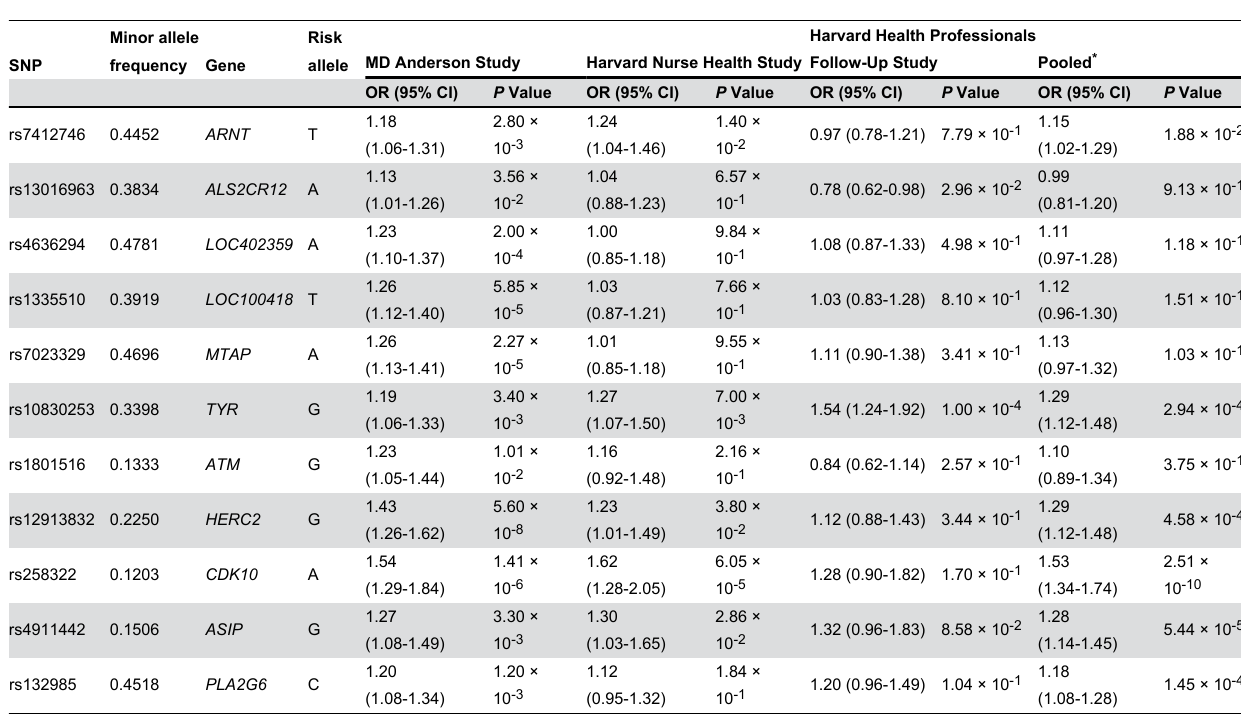
Table 2. Association with melanoma risk for 11 previously identified melanoma risk variants.